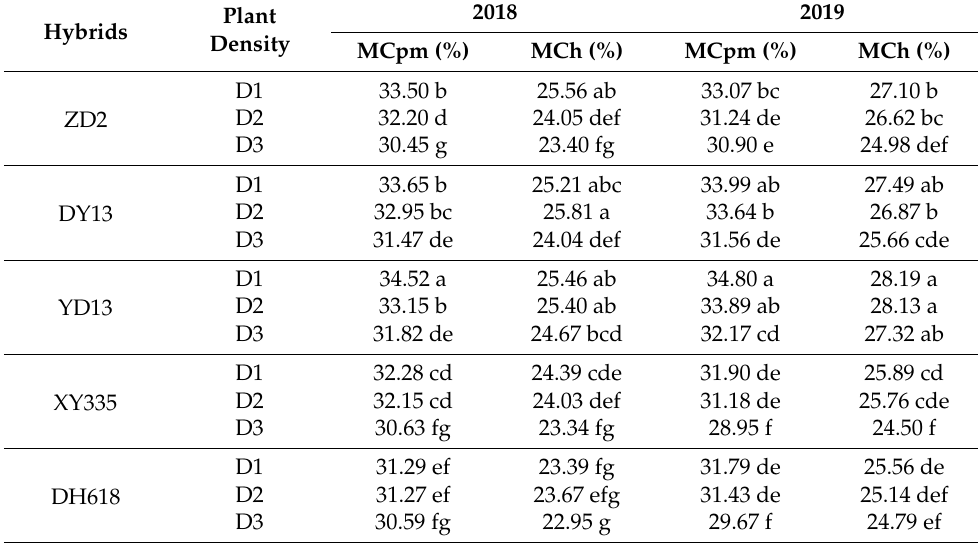
Table 5. Grain water content of different hybrids at physiological maturity and harvest stage under different densities in 2018 and